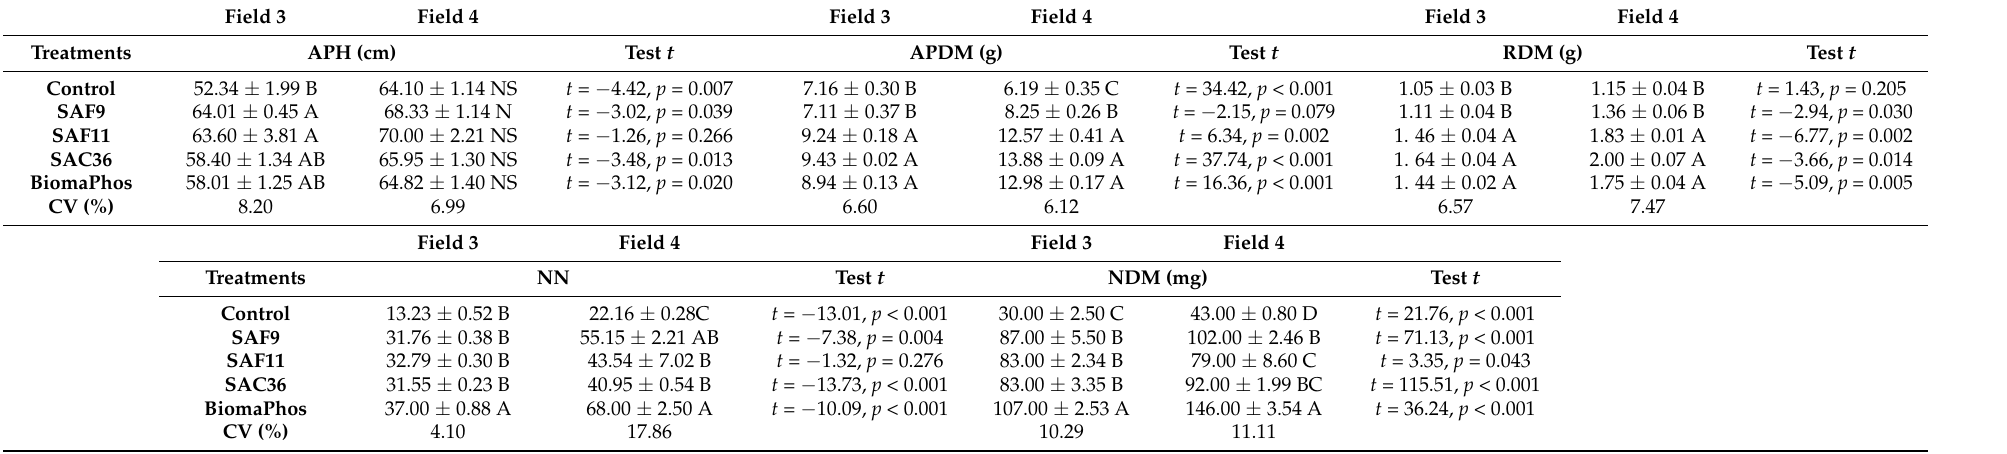
Table 5. Effect of inoculation with plant-growth-promoting rhizobacteria on aerial part height (APH), aerial part dry mass (APDM), root dry mass (RDM), number of nodules (NN), and nodule dry mass (NDM) of Glycine max L. plants grown in the summer 2020/2021, in two experimental fields of soybean cultivation, in the interior of the state of Goi á s, Brazil, with different histories of soybean cultivation: Field 3, soybean production for 10 years and Field 4, second year of soybean